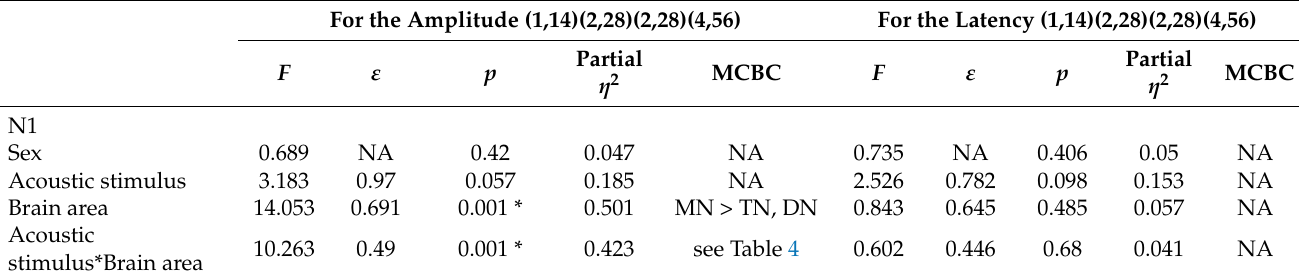
Table 3. Results of ANOVA for amplitudes and latencies of N1 with respect to the three factors for the experiments recruiting reflexive attention.